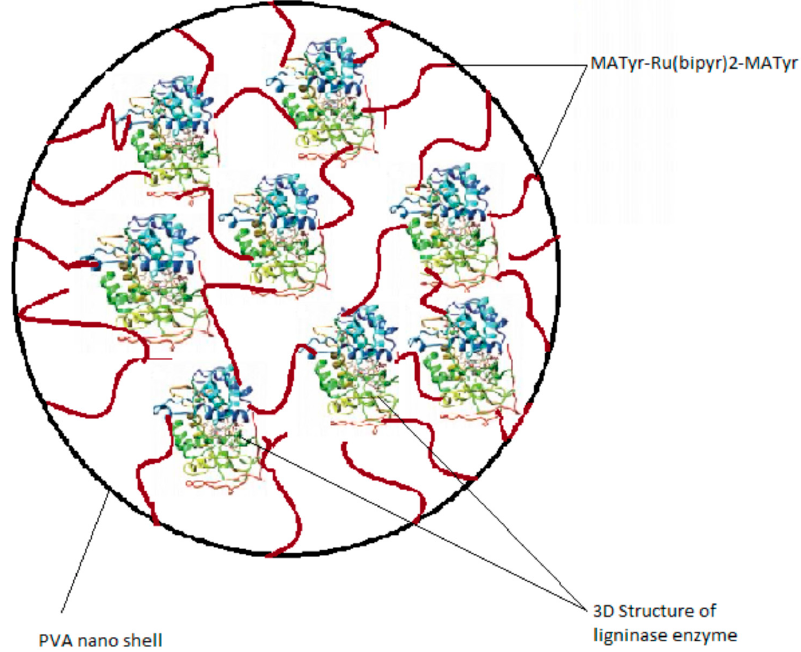
Figure 2. Schematic illustration of the synthesized nano lignin peroxidase enzyme.